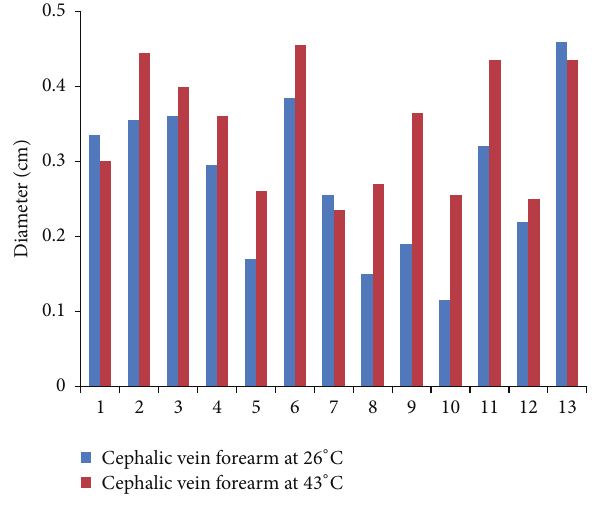
Figure 1: Diameter of cephalic vein at forearm.